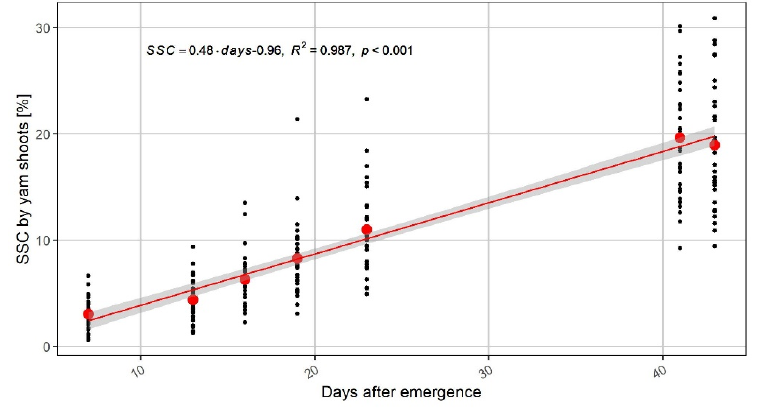
Figure 7. Relationship between the proportion of soil surface cover by yam shoots (SSC expressed in %) derived from the number of plant pixels measured in TGI images and average over all the plants and time (days after 80% of emergence) in a field experiment conducted with water yam (cv C18) in Tieningboué (Côte d’Ivoire). Each dot represents the value per plant and red dots represent the average values for all 32 plants. The grey band indicates the 95% confidence interval.